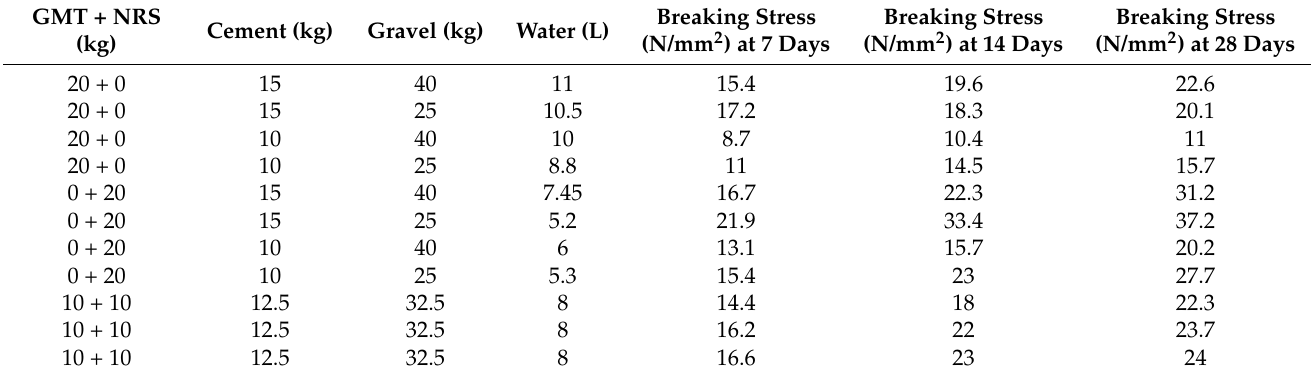
Table 5. Concrete compressive strength of different dosages by the day 7, 14 and